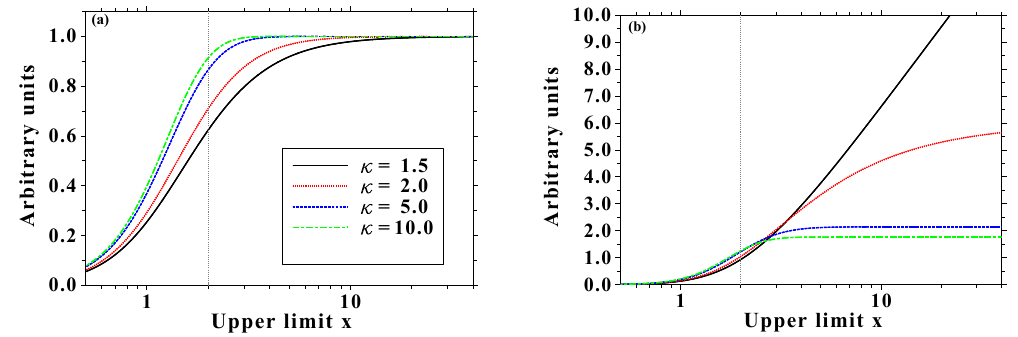
Figure 6. The truncated moments M 0 κ,x (a) and M 2 κ,x (b) for different κ values. The logarithmic x axis displays the speed normalized to 100kms − 1 and the y axis is in arbitrary units. See text for details. The dotted vertical line indicates a speed of roughly 200km s − 1 , which is about the solar wind speed in the heliosheath. A speed about 30 units corresponds to that of protons as measured in the lowest-energy channel of the LECP instrument onboard